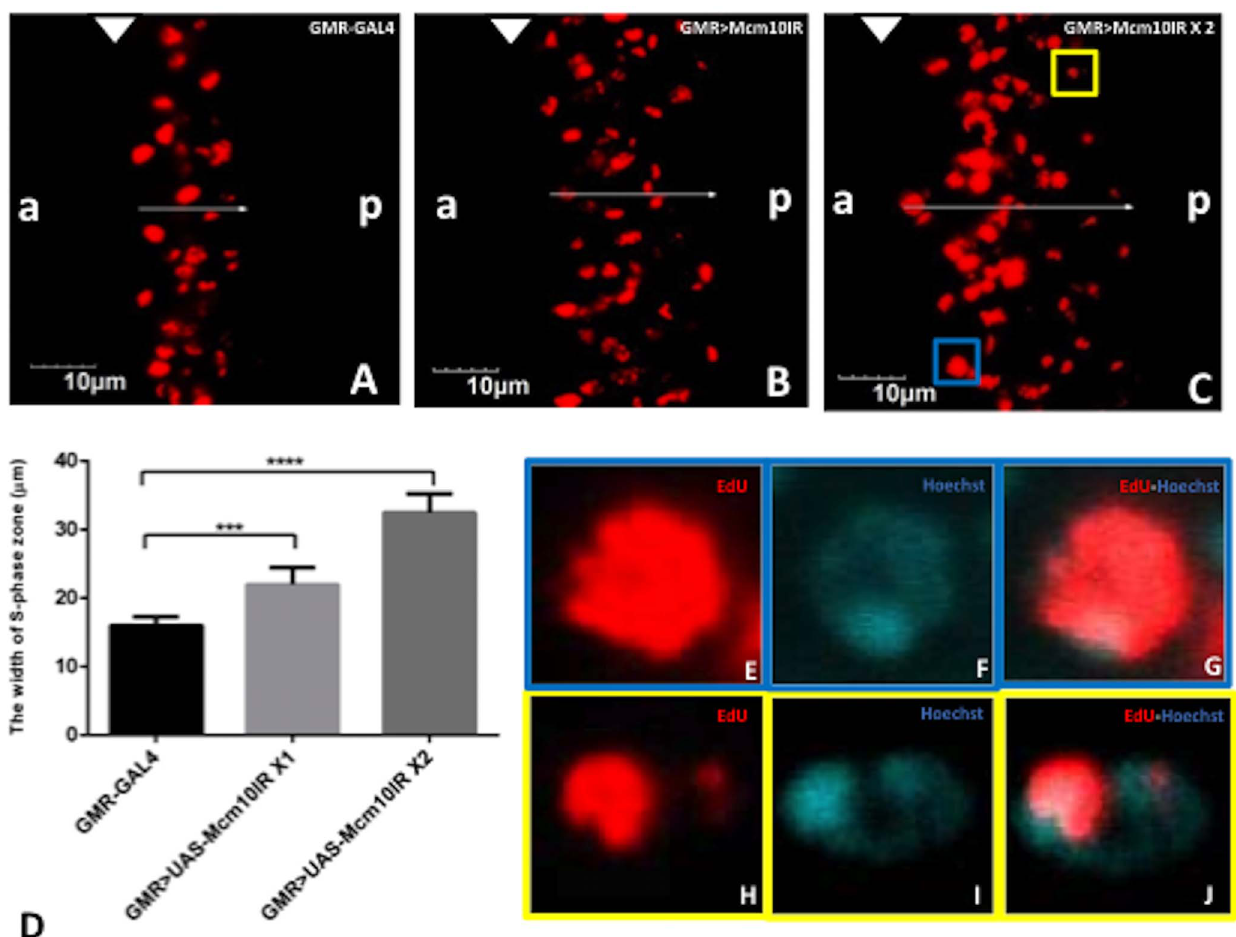
Figure 4. Knockdown of dMcm10 in eye imaginal discs induces a delay in S phase. The eye imaginal discs were labeled with EdU (Red) (A) GMR -GAL4/ + ; + ; + ; (B) GMR -GAL4/ + ; + ; UAS- Mcm10IR 633-700 / + ; (C) GMR -GAL4/ + ; + ; UAS- Mcm10IR 633-700 /UAS- Mcm10IR 633-700 . The arrows show the positions measured. (D) Quantification of the width of S phase zone in the posterior region. ***p , 0.001, ****p , 0.0001. The yellow square shows the position of an EdU cell possibly undergoing replication of the late replicating heterochromatic region. The blue square shows the position of an EdU cell possibly undergoing replication of the early replicating euchromatic region. Figure E–G present higher magnification images of the blue square. Figure H–J present higher magnification images of the yellow square. Cells were stained with EdU (Red) (E and H) or Hoechst 33342 (Blue) (F and I). Figures G and J are merged images of both EdU and Hoechst 33342. The bars indicate 10 m m. The flies were reared at 28 u C. White arrowheads indicate morphogenetic furrow (MF). (a) indicates anterior, (p) indicates